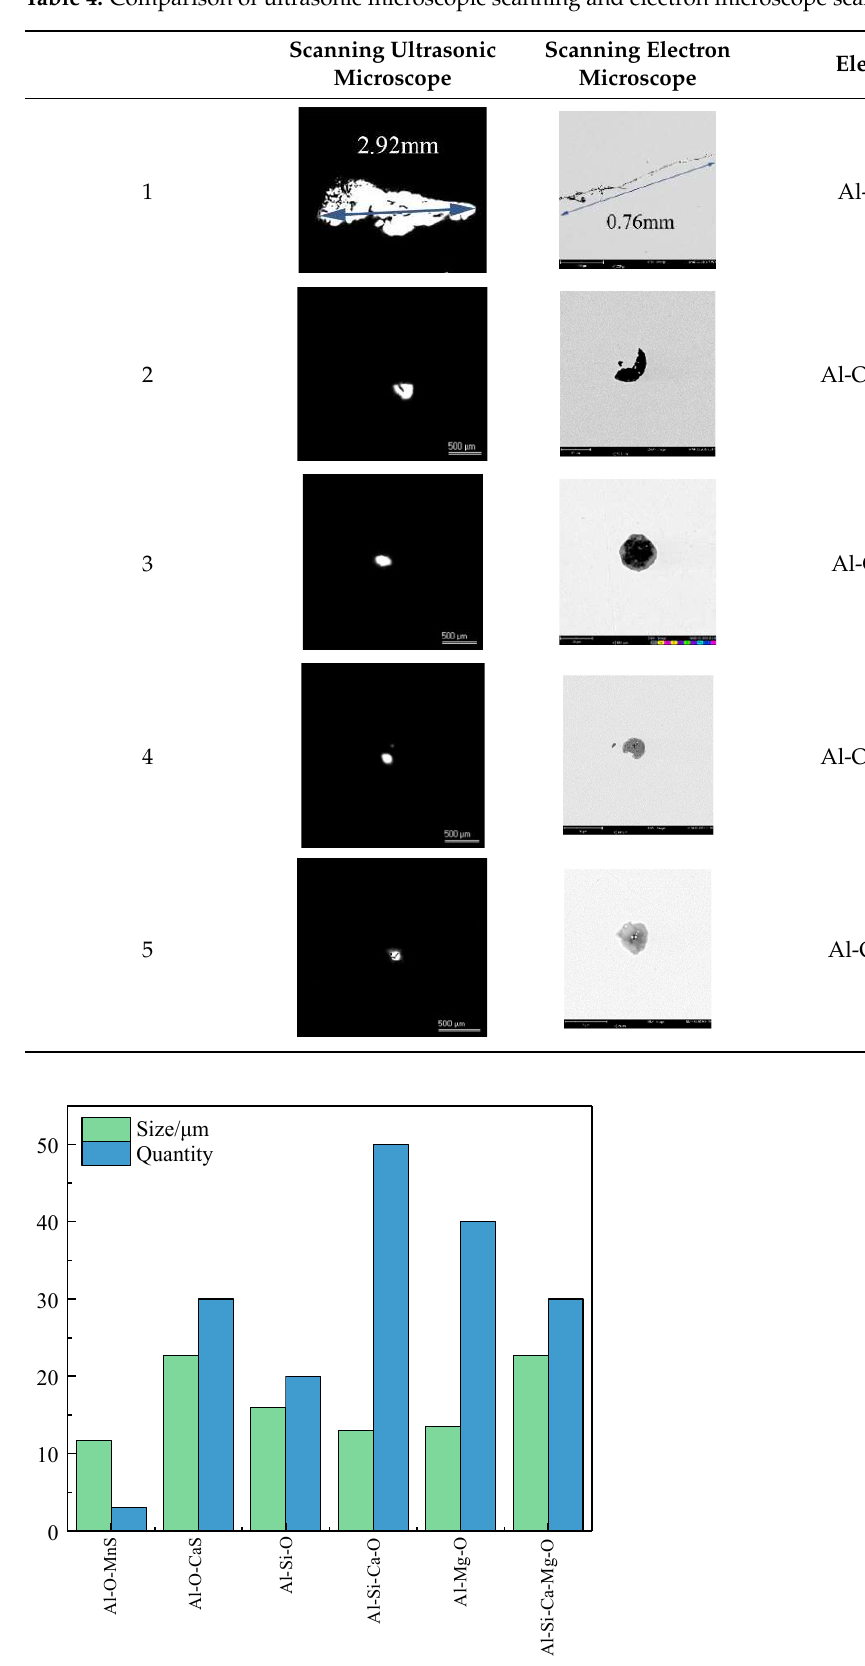
Figure 9. The number and the average size of inclusions of different